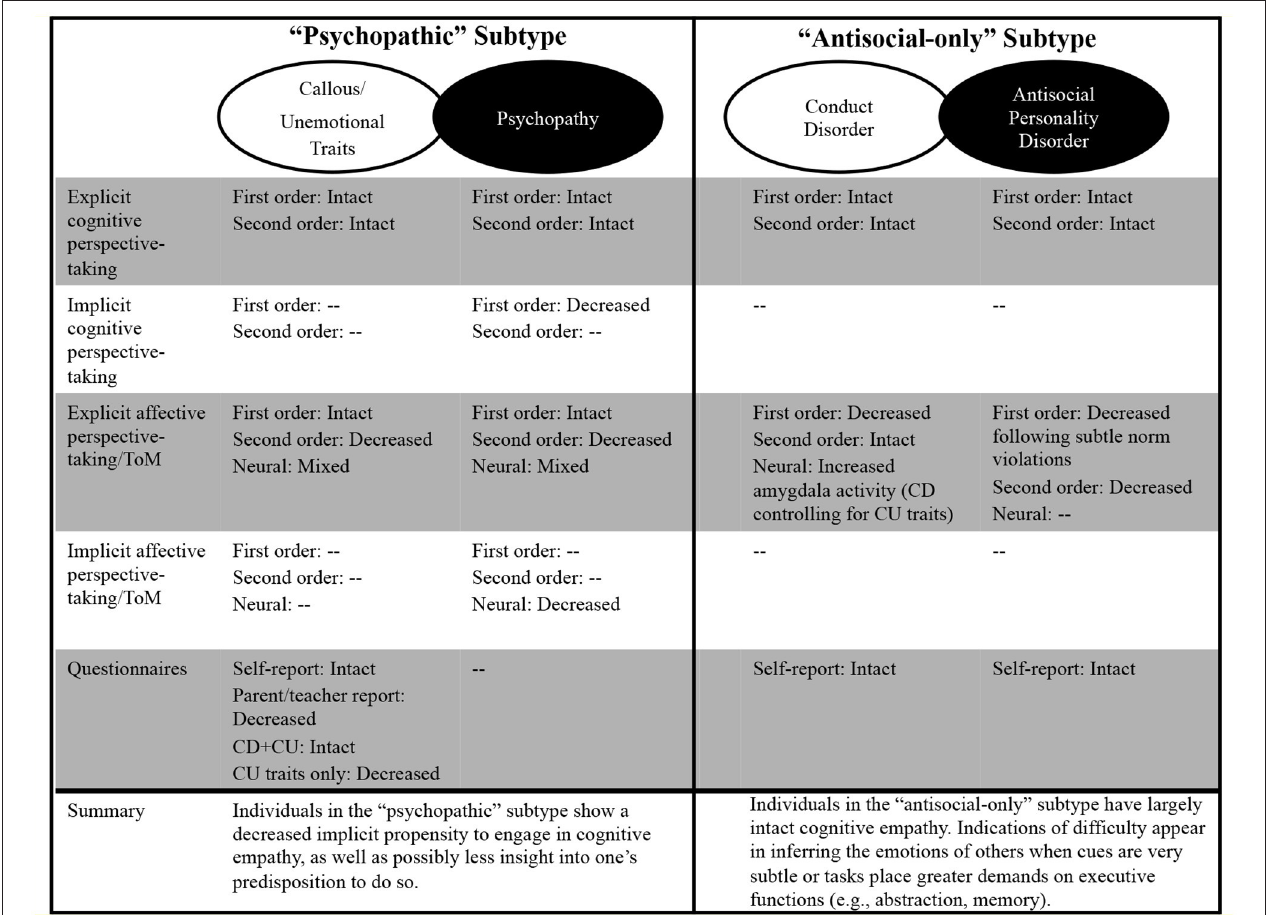
FIGURE 2 | Summary of cognitive empathy findings by subtype of antisocial individual. CU, callous-unemotional; CD, conduct disorder; ToM, theory of mind; --, indicates no research to